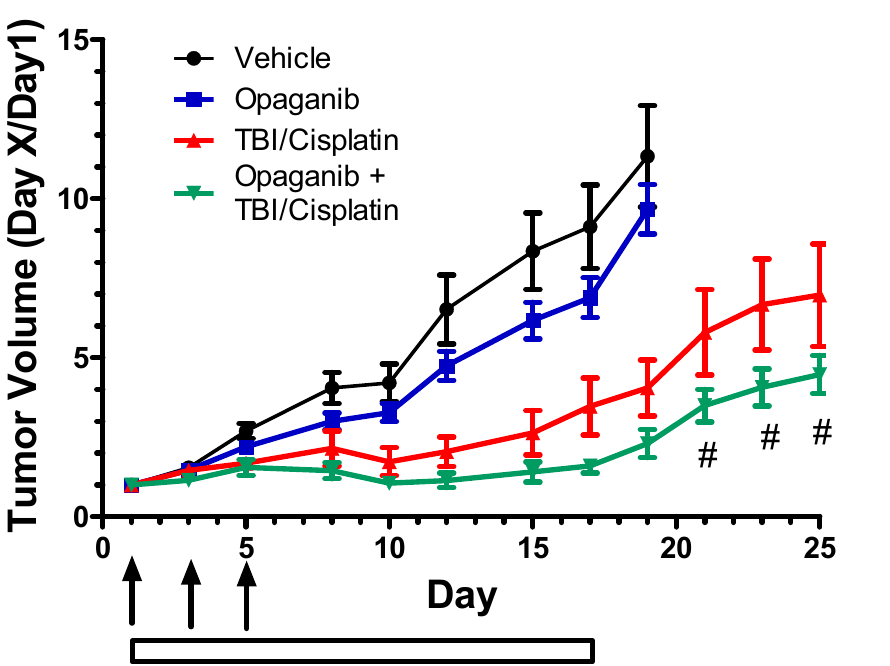
Figure 10. Antitumor efficacy of opaganib and chemoradiation toward Head and Neck SCC tumors. NCr nu/nu mice were injected subcutaneously with human FaDu tumor cells. When tumors reached 100–150 mm 3 , mice were randomized and treated with: Vehicle alone ( ● ); opaganib 50 mg/kg/day, 5×/week ( ∎ ); fractionated TBI (3 Gy, 3 times ↑ ) plus cisplatin (2 mg/kg on all TBI days, 2 h pretreatment) (TBI + cisplatin) ( ); or TBI + cisplatin + opaganib ( ). Mice in the combination group were treated with opaganib 2 h prior to radiation. # indicates p < 0.02 for TBI + cisplatin + opaganib compared with TBI + cisplatin.